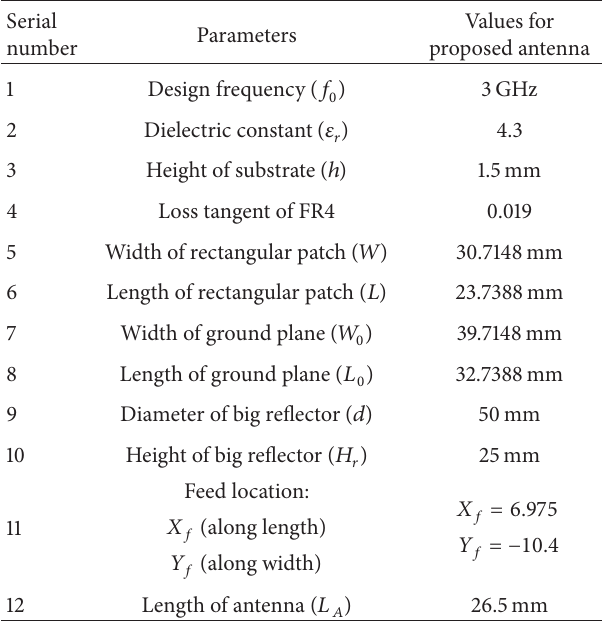
Table 3: Mathematical calculation for the proposed antenna.